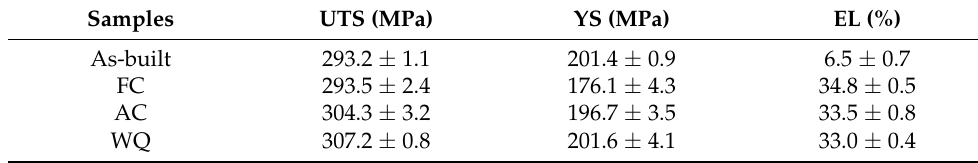
Table 3. High-temperature tensile